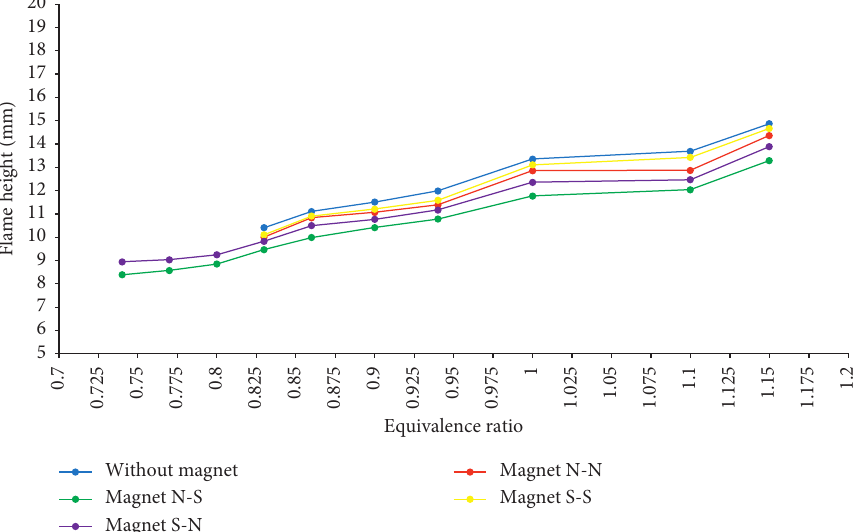
Figure 10: Flame height of coconut oil versus equivalence ratio at various magnetic field orientations and without magnetic